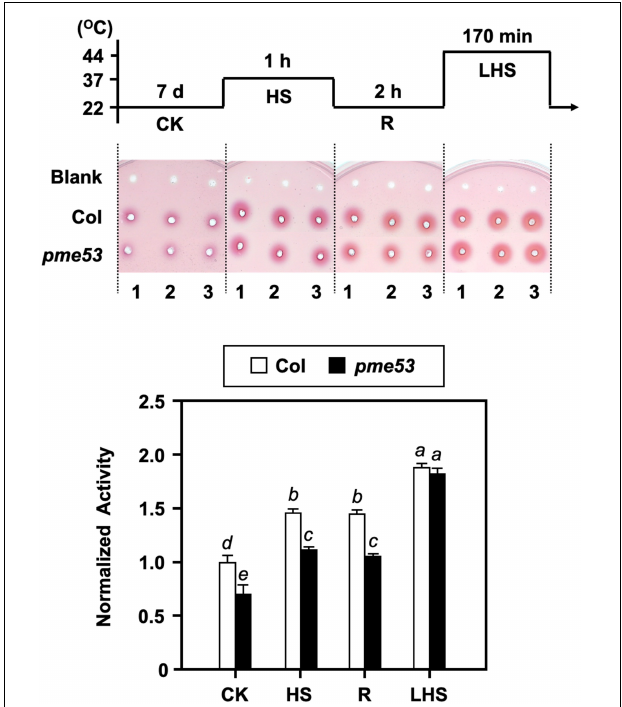
FIGURE 8 | PME activity in pme53 mutant plants in response to heat stress. The pictogram shows the heat stress regime. PME activity in 7-day-old seedlings was analyzed. The ruthenium red-stained zone diameters resulting from the hydrolysis of esterified pectin in an agarose gel by diffusion were photographed and measured. The fold change PME activity was normalized relative to level of the Col control (CK). Blank, the buffer used only. Data are mean ± SE of three biological replicates. Statistical significances among groups are indicated using different letters (Tukey’s HSD